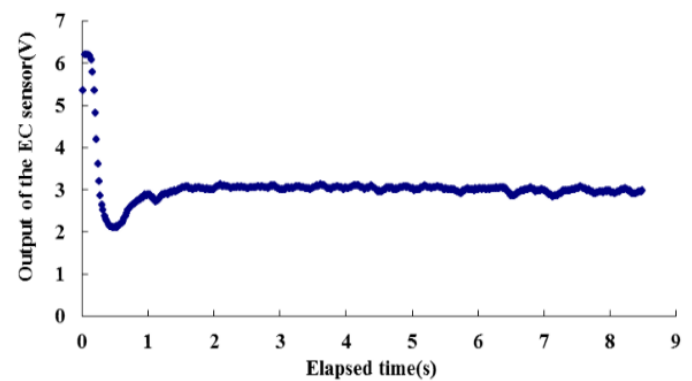
Figure 12. Output of the EC sensor when the desired output of the flowmeter was set at 8 V (equivalent to a desired chemical flow rate set at 11.8 mL/min).